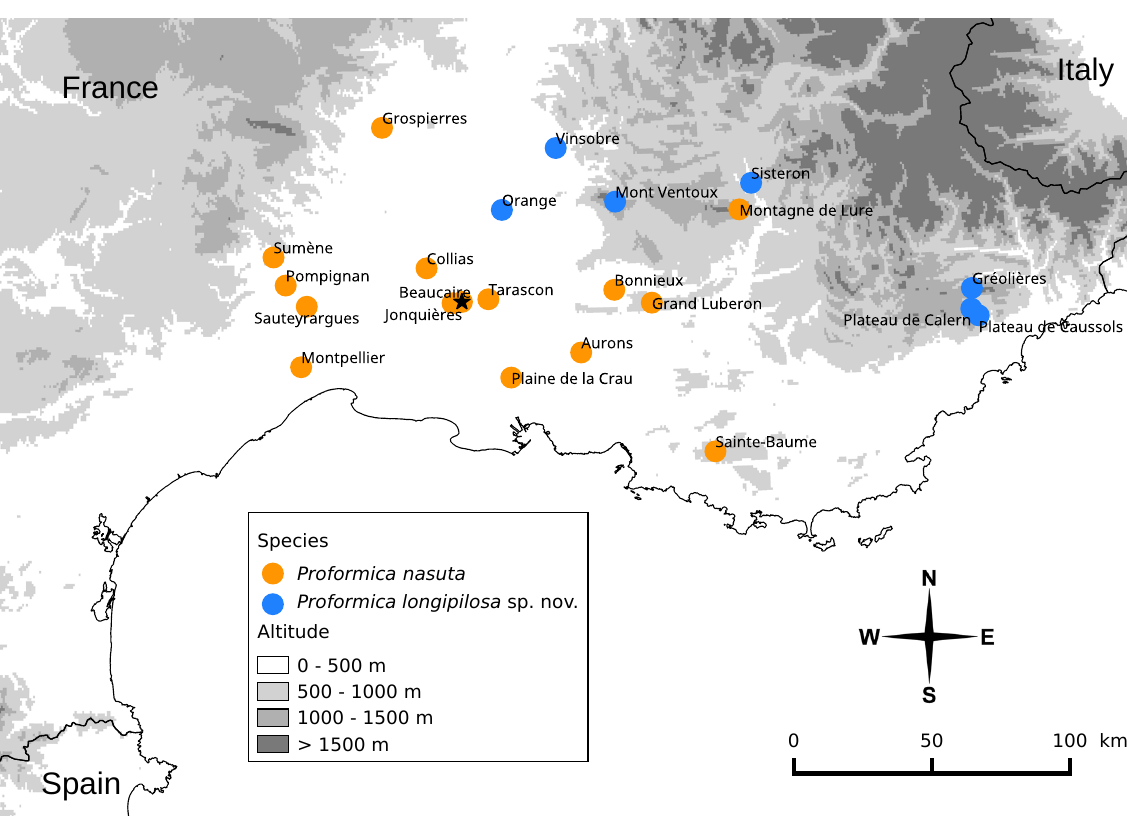
Fig. 1. Distribution of the 22 localities where Proformica nest samples were collected. The star indicates the type locality of Proformica nasuta (Nylander, 1856) (i.e.,